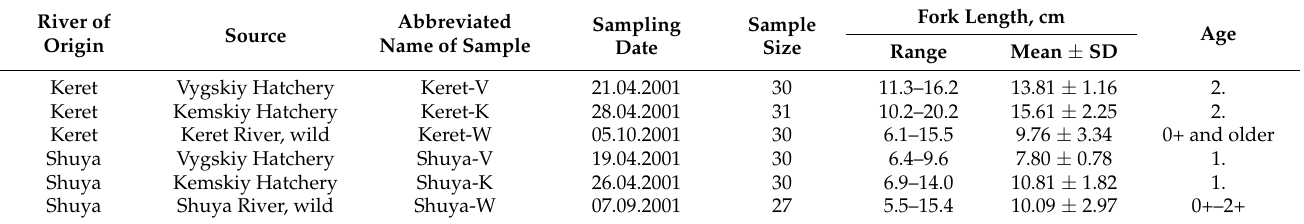
Table 1. Characteristics of the juvenile Atlantic salmon samples examined in this